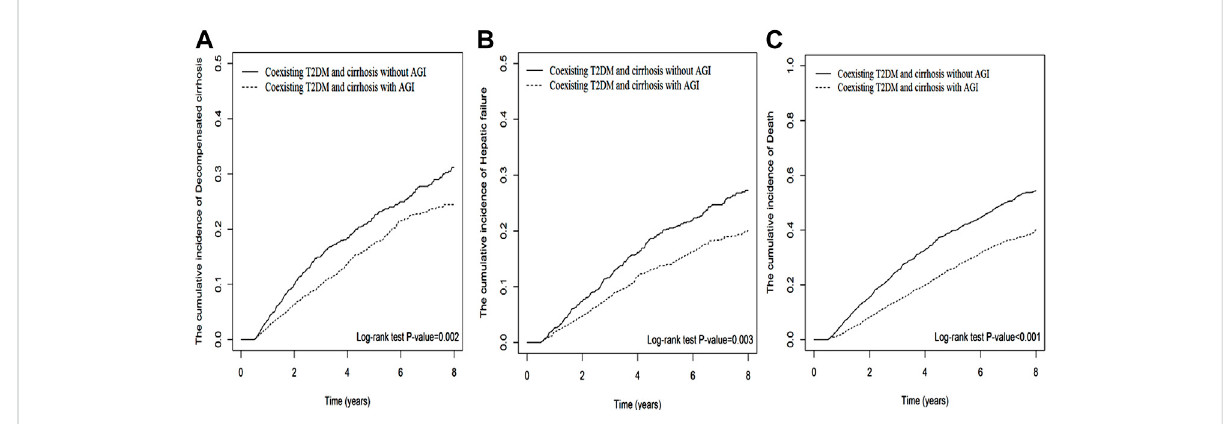
FIGURE 3 The cumulative incidences of decompensated cirrhosis (A) , hepatic failure (B) , and death (C) between AGI users and non-users in patients with T2DM and compensated liver